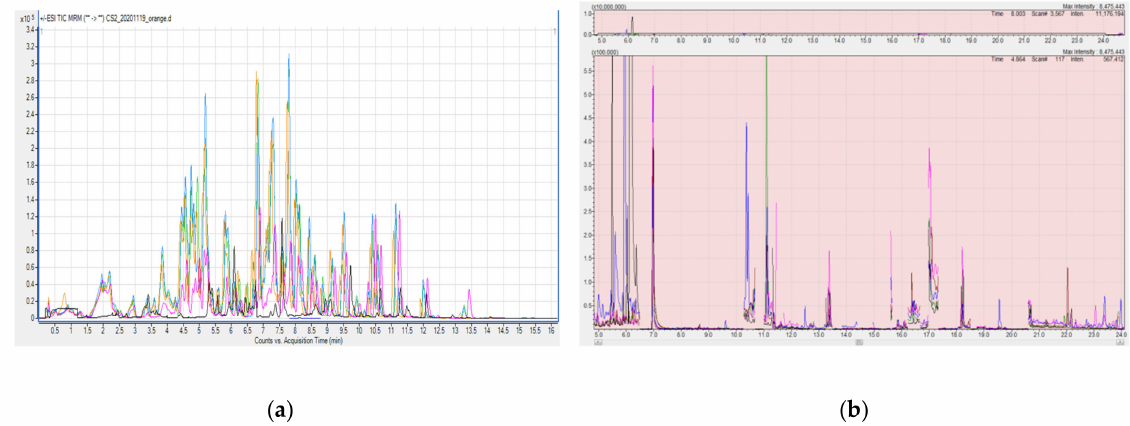
Figure 1. TIC chromatograms of total pesticides, each at a concentration of 0.010 mg/kg, in all five validated commodities, extracted from: ( a ) LC-MS/MS; ( b ) GC-MS/MS (horizontal axes: retention time in minutes, vertical axes: intensity × 10 5